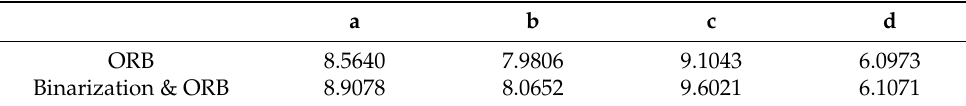
Table 2. Information entropy of different splicing algorithms.